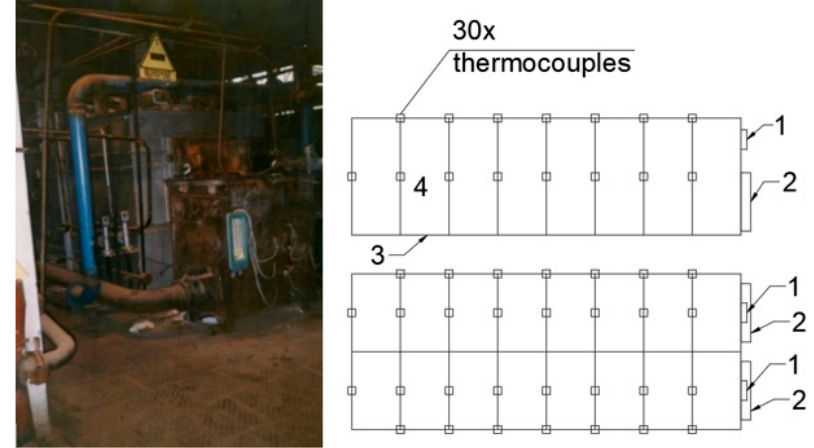
Figure 4. Reheating furnace and locations of installed thermocouples. 1—burners, 2—regenerators, 3—working chamber, 4—calculation zones.